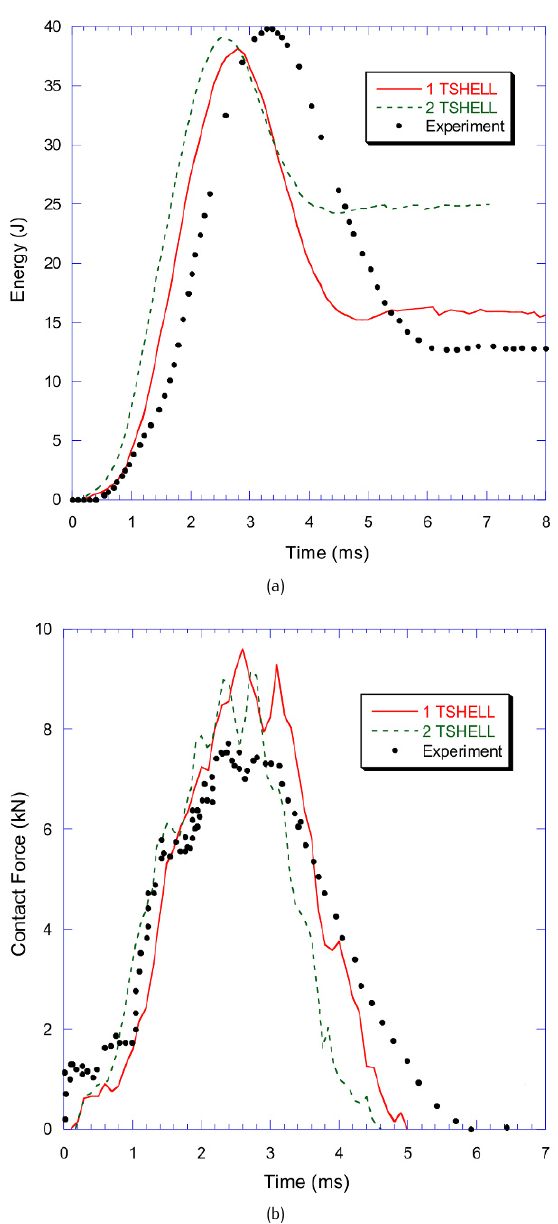
Figure 5. Impacted laminated plate modelled with TSHELL elements (a) internal energy and (b) contact force. Experiment from